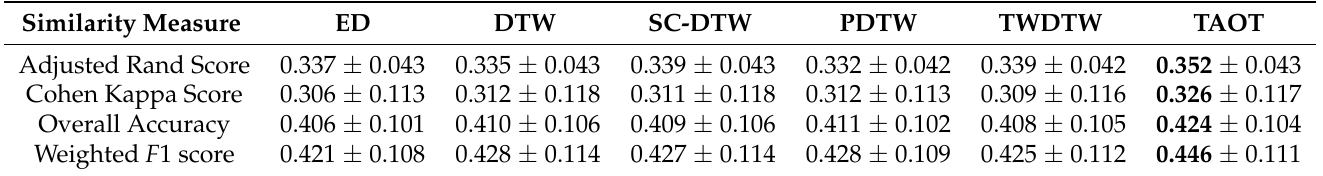
Figure 5. Clustering maps of Reunion Island dataset generated by different similarity measures and the ground truth reference map of Reunion Island dataset. ( a ) Euclidean distance; ( b ) DTW; ( c ) SC-DTW; ( d ) PDTW; ( e ) TWDTW; ( f ) TAOT; ( h ) Reference map. Table 3. Comparison of clustering performance on Reunion Island dataset with random initial cluster centers. The best results are shown in